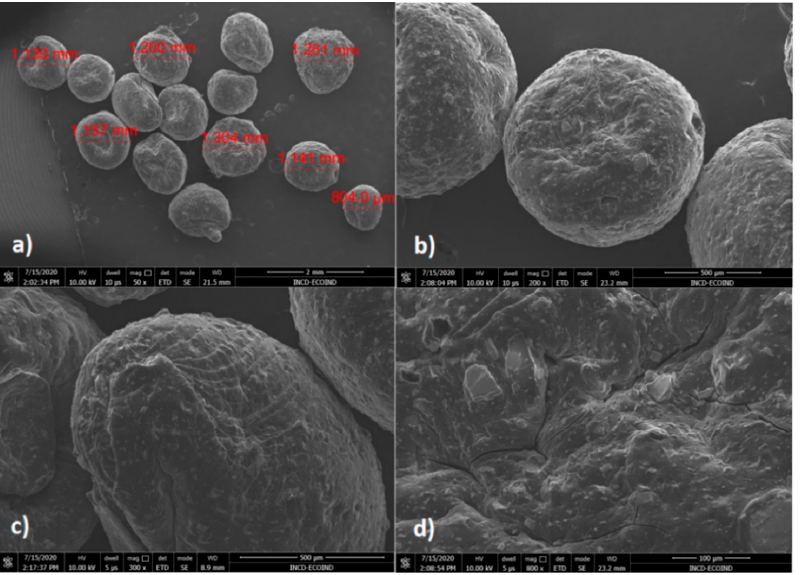
Figure 7. SEM images of CoFe 2 O 4 –Chit at different magnifications: ( a ) 50×, ( b ) 200×, ( c ) 300×, ( d ) 800×. The magnetic properties of CoFe 2 O 4 and CoFe 2 O 4 –Chit were measured on a VSM at room temperature by recording the magnetization versus applied field curves (Figure 8). revealing a superparamagnetic behavior of both samples. The experimental data were analyzed by fitting to the Langevin function. The saturation magnetization (Ms) values are 33.6 emu/g for CoFe 2 O 4 and 8.4 emu/g for CoFe 2 O 4 –Chit. The decrease in Ms value of CoFe 2 O 4 –Chit compared to CoFe 2 O 4 is due to the presence of the diamagnetic chitosan molecules.